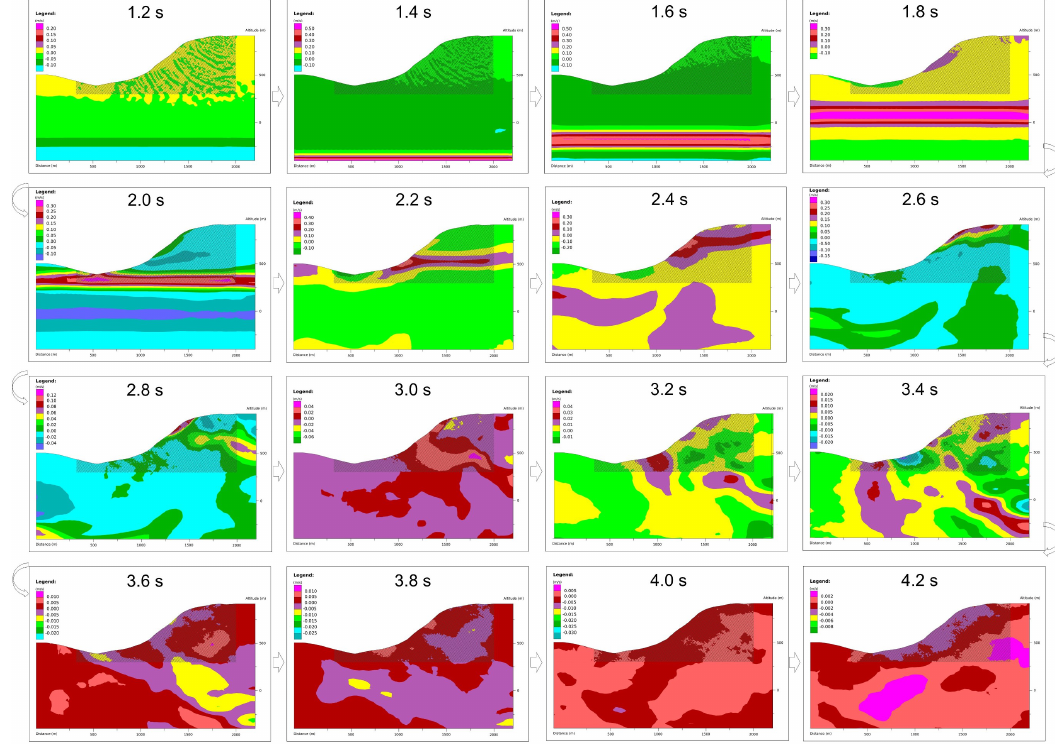
Figure A4. Dynamic modelling results for the rock slope conditions closest to the Balta case, with structure 8, plot with the xvelocity propagation (cyle time